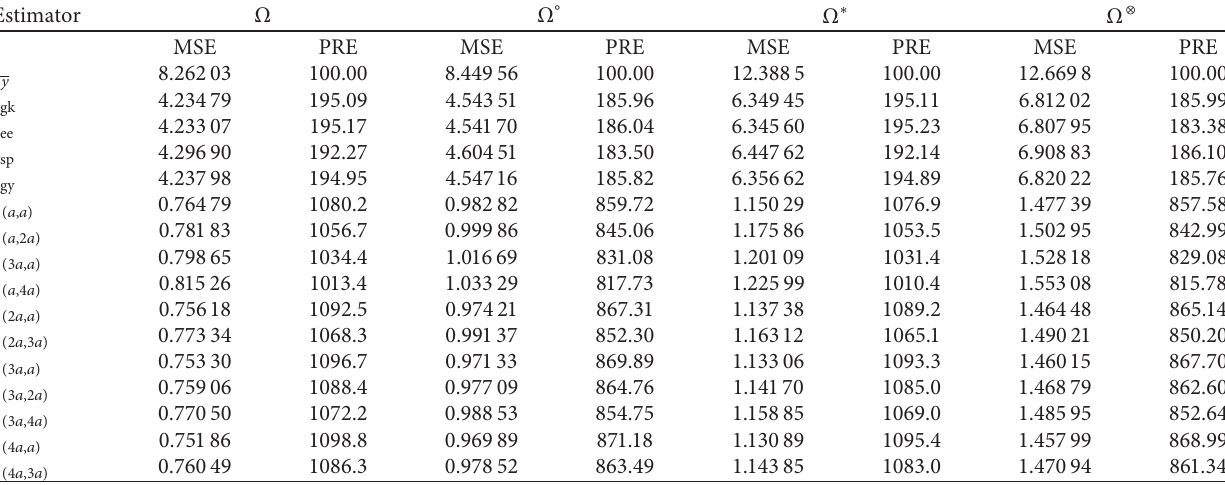
Table 2: MSE and PRE of the estimators for n � 80.